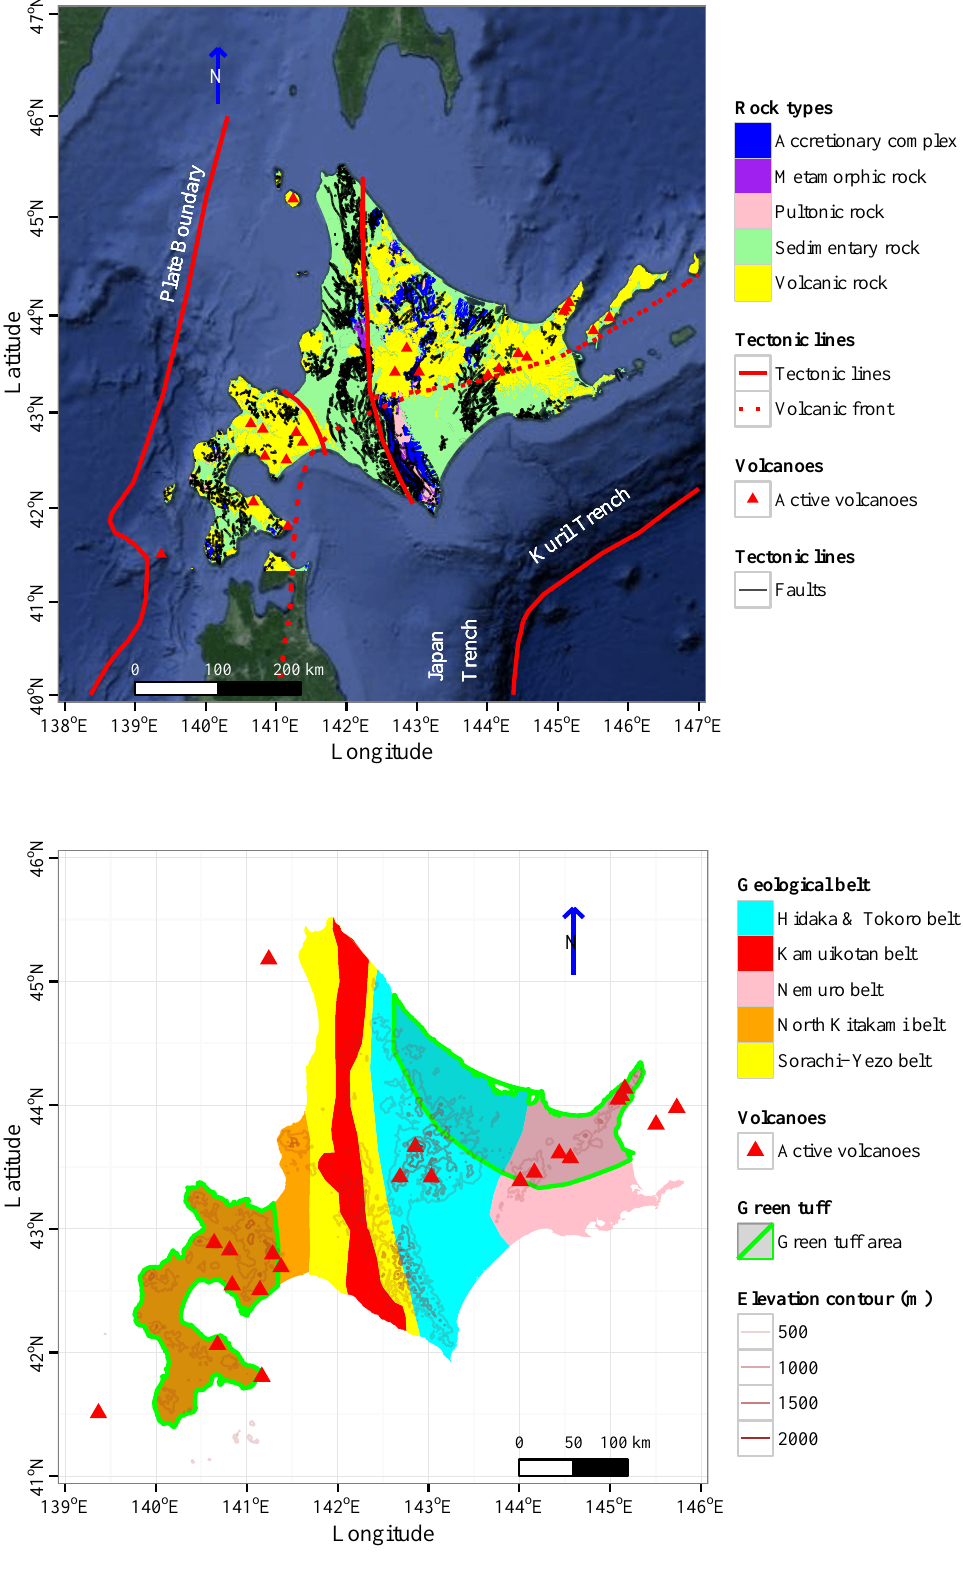
Figure 2. Geological settings and main rock types of Hokkaido island [22] ( top ); and distributions of geological belts, green tuff areas and elevation contours [22,23] ( bottom